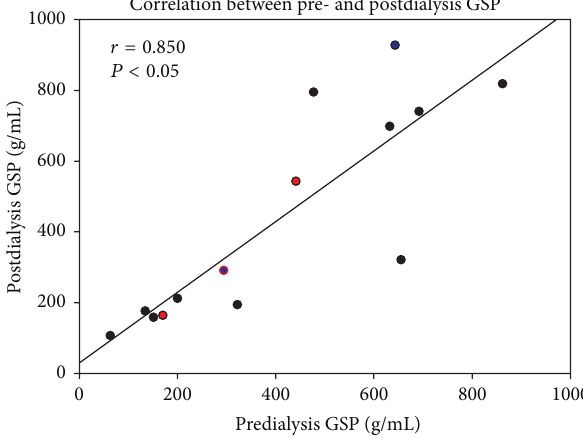
Figure 3: Significant positive correlation ( 𝑟 = 0.853 , 𝑃 < 0.05 ) between galactose single-point (GSP) values beforeand after a single hemodialysis session in 14 patients. Red circles: hepatitis B virus (HBV) carriers ( 𝑛 = 2 ); blue circles: hepatitis C virus (HCV) carriers ( 𝑛 = 2 ).